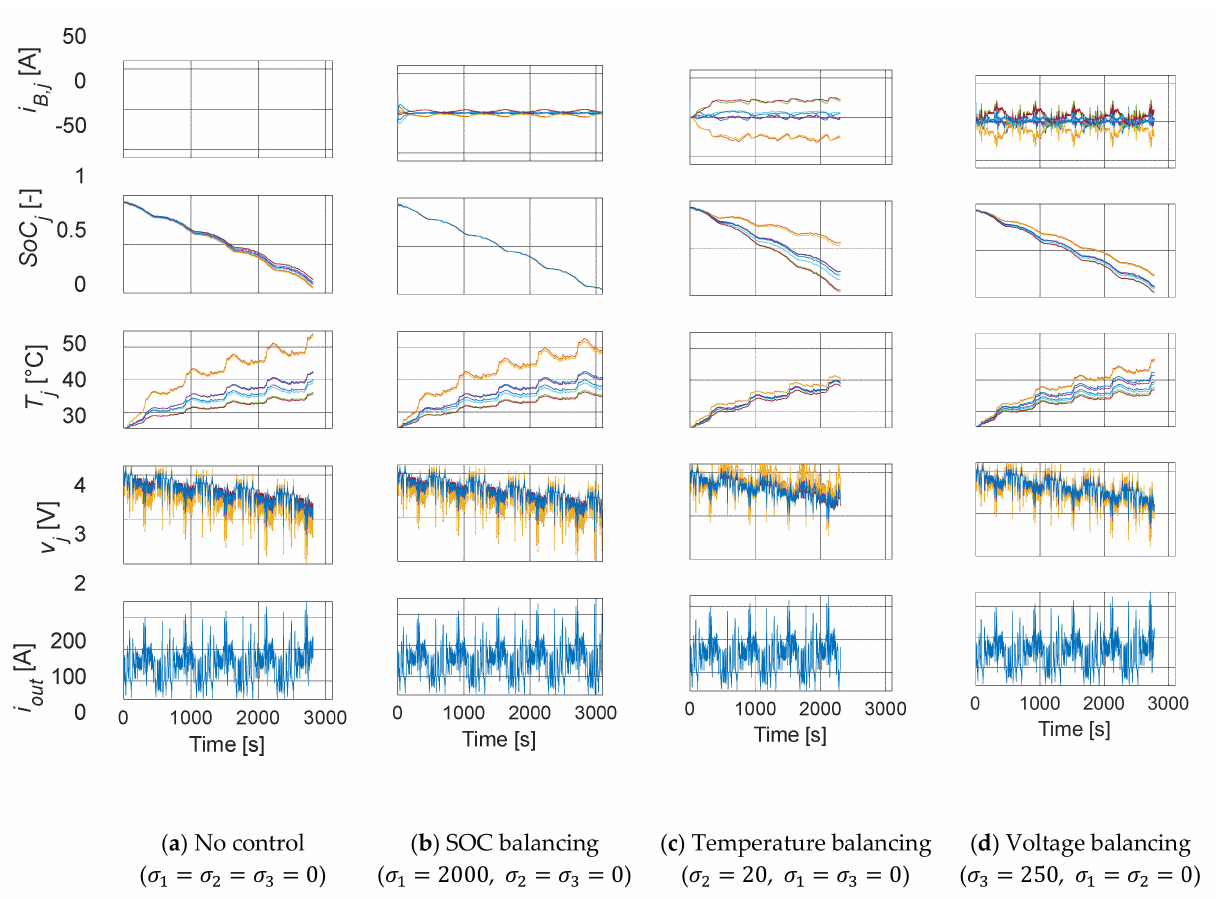
(cid:16) (cid:17) ≤ 0.5. Scenario: aggressive driving (US06), mixed SOC j